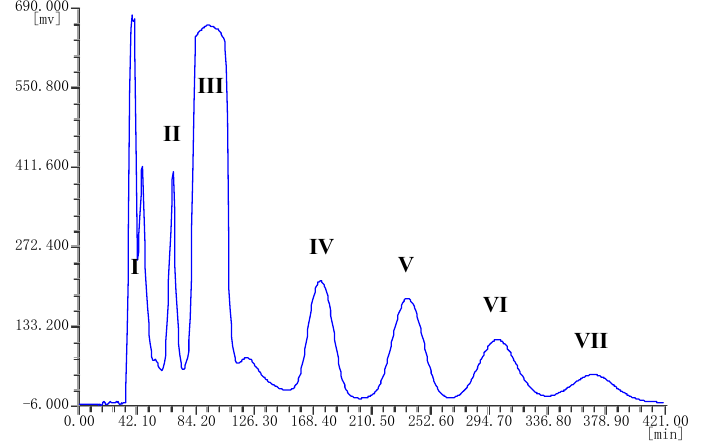
Figure 2. HSCCC chromatogram of the ethyl acetate crude extract from endophytic fungus Berkleasmium sp. Dzf12 with n -hexane-chloroform-methanol-water (1.5:3.0:2.5:2.0, v/v) solvent system.